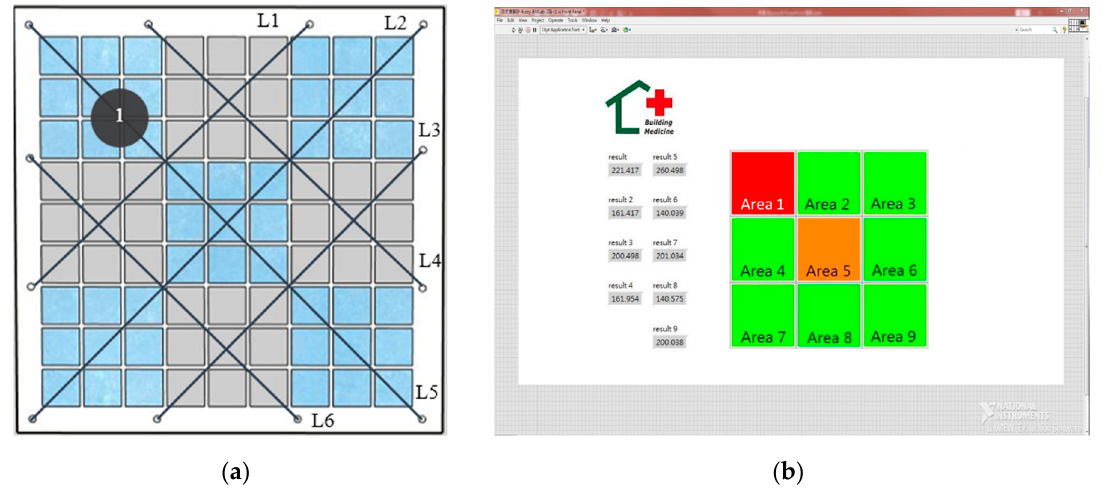
Figure 9. ( a ) Schematic of the compression point 1 and ( b ) area values and hazard levels.